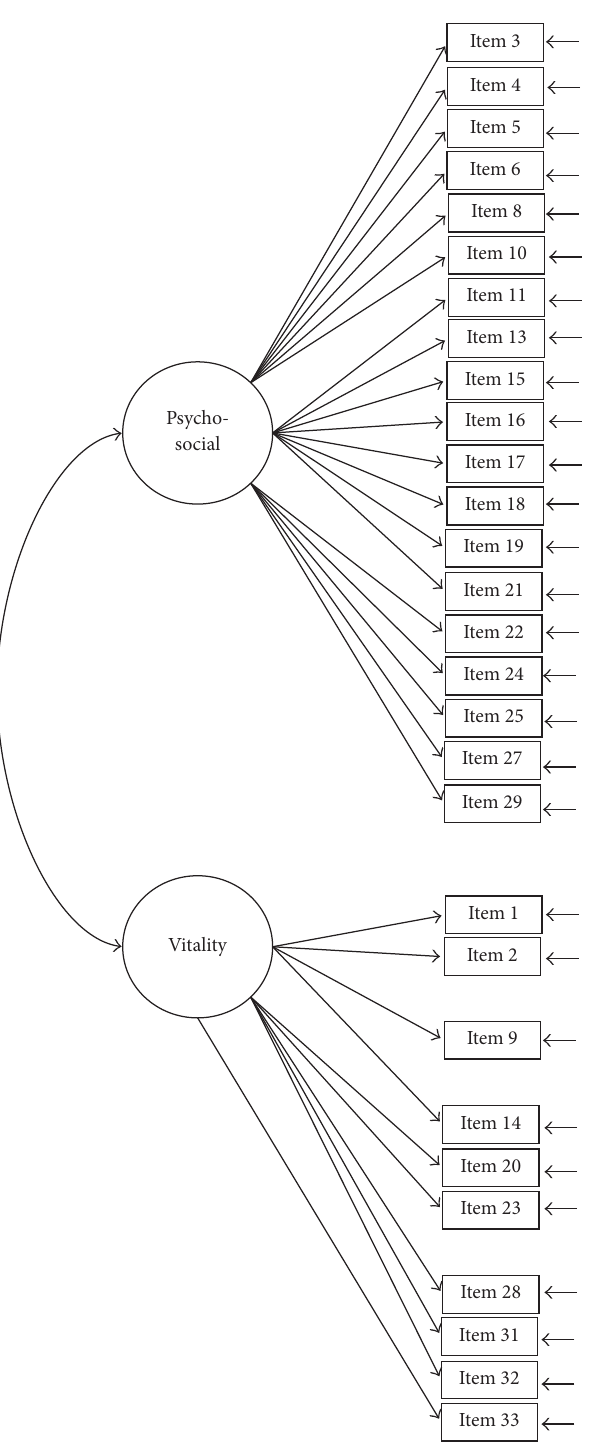
Figure 2: Model 2: the two-correlated-factor model with 29 items. Item descriptions are in Table